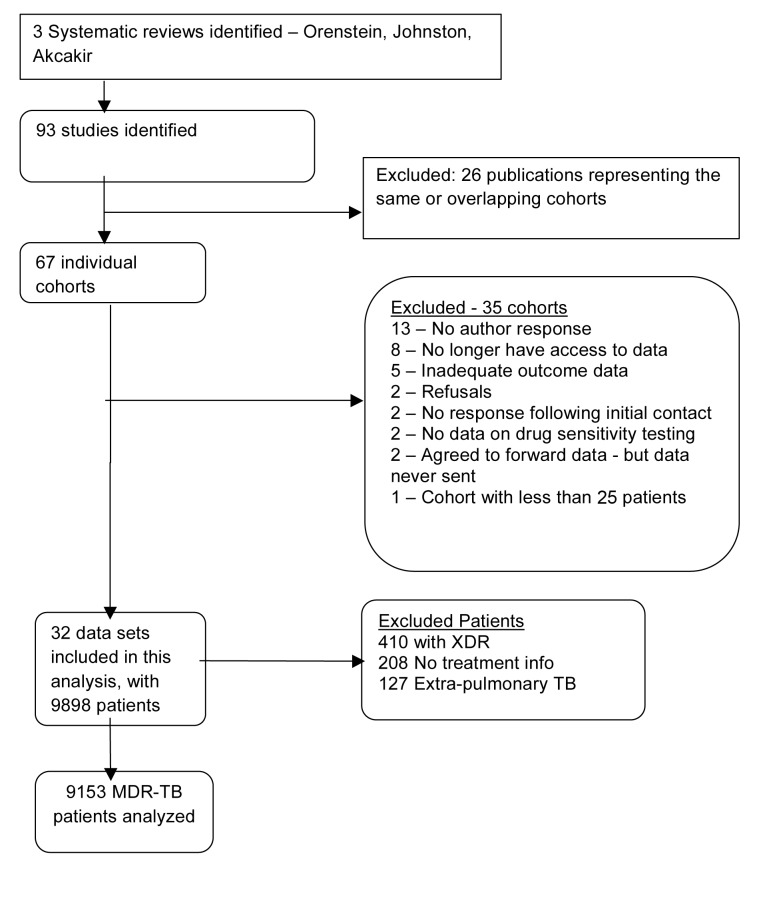
Study selection.